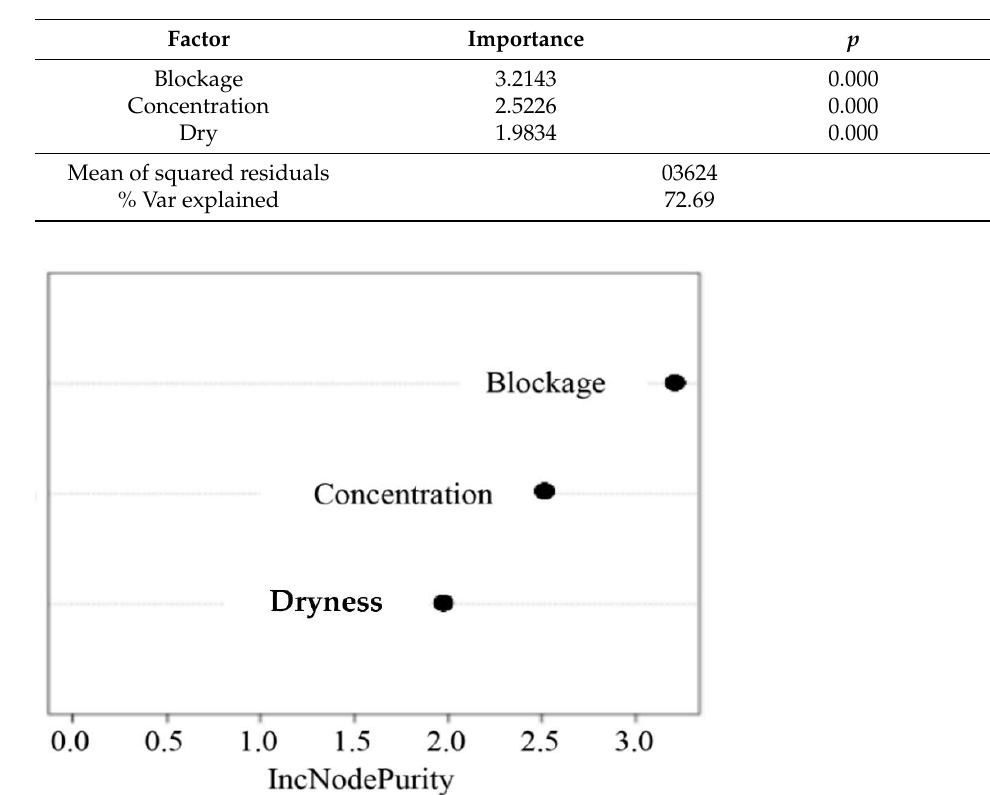
Figure 15. Random forest tree case. Table 5. Evaluation of the factor importance of the random forest model.